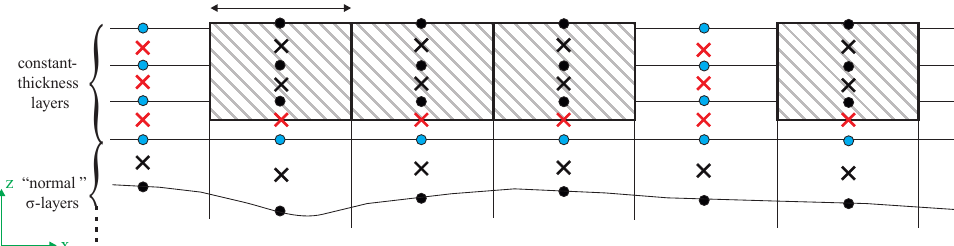
Figure 1. Sketch of the grid organization and spatial arrangement of variables in the coupled wave–ice model, for the case of three constant- thickness uppermost layers ( N l , ice = 3) accommodating the ice “grains” (dashed boxes). Crosses denote velocity points, while dots are the pressure points. Locations in which the immersed-boundary forcing is applied are shown in red, while pressure points affected by the boundary are in blue (note that, in accordance with the immersed boundary method, the model equations are solved everywhere inside the model domain, independently of ice being present in a given grid cell or not). See text for more details.